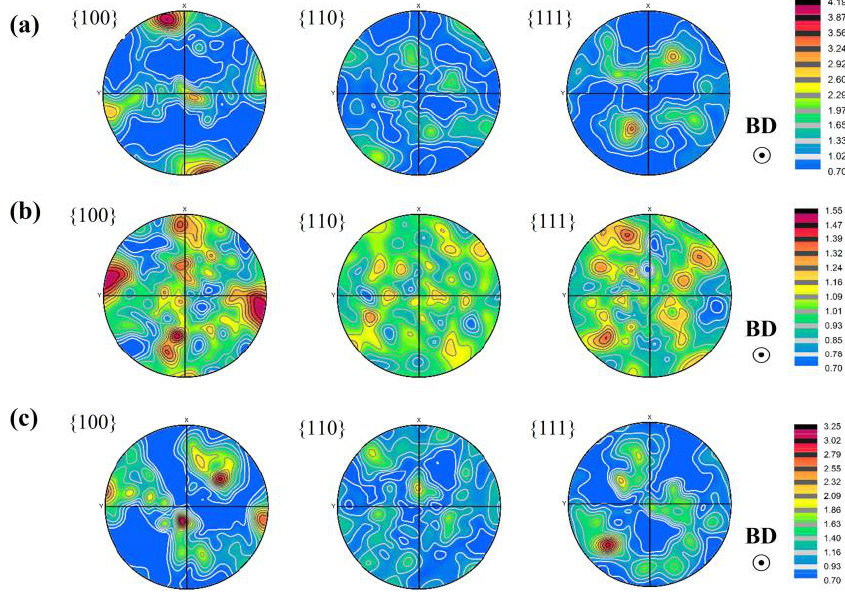
Figure 9. Pole figures of the longitudinal direction: ( a ) S0, ( b ) S1, ( c ) S4. The effect of the Y 2 O 3 content on the grain size of the Y 2 O 3 -AlSi10Mg composite spec-